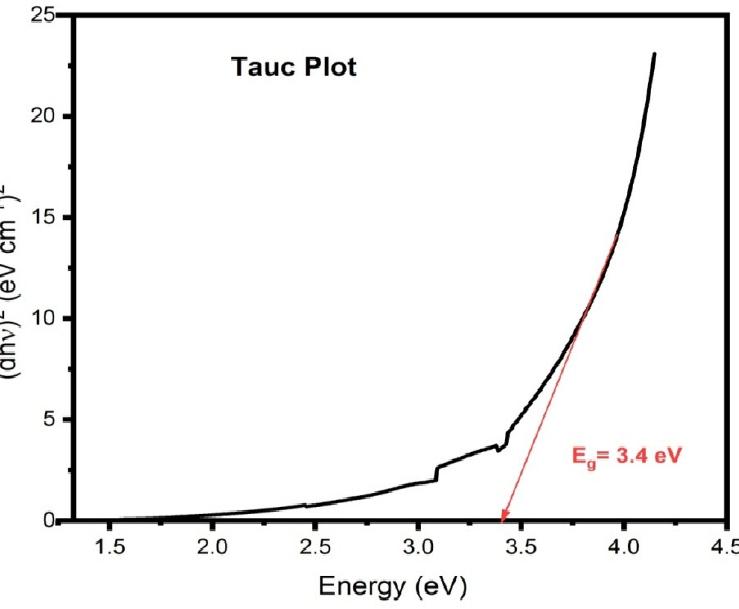
Figure 2. UV-vis spectrum of zinc oxide nanoparticles synthesized using aqueous pomegranate ex- tract (Peak 3: 506 nm; Peak 4: 367 nm).